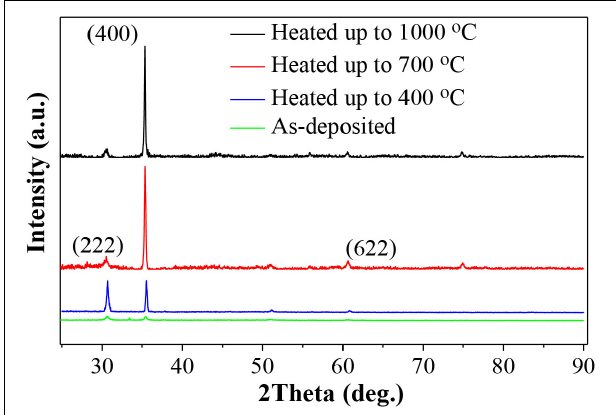
FIGURE 3 | XRD patterns of the ITO films deposited onto LGS substrates, annealed at different